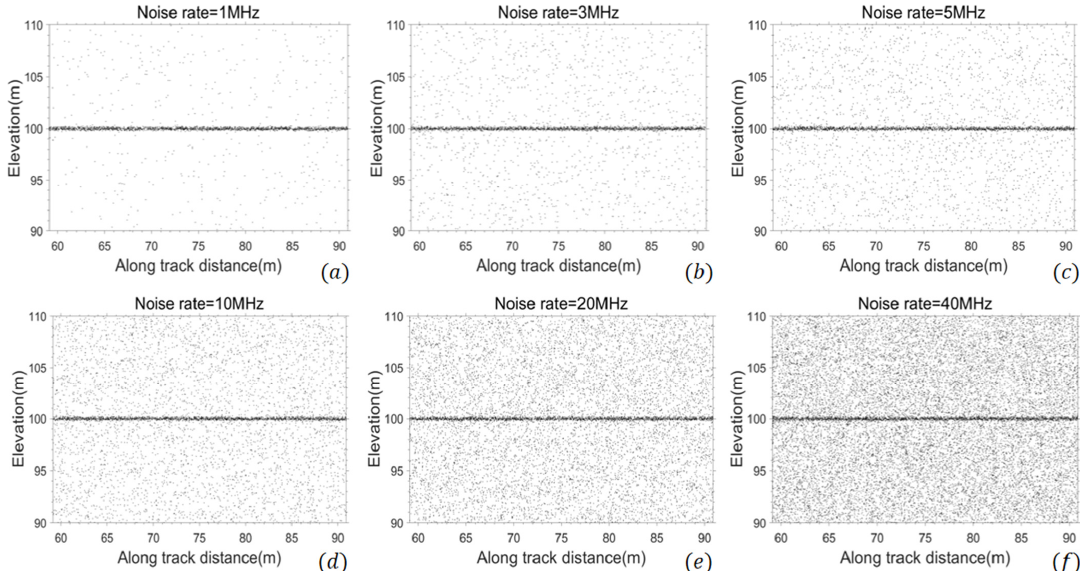
Figure 5. Results from noise photon events and signal photon events ( p = 0.55). ( a ) Background photon count rate is 1 MHz. ( b ) Background photon count rate is 3 MHz. ( c ) Background photon count rate is 5 MHz. ( d ) Background photon count rate is 10 MHz. ( e ) Background photon count rate is 20 MHz. ( f ) Background photon count rate is 40 MHz.